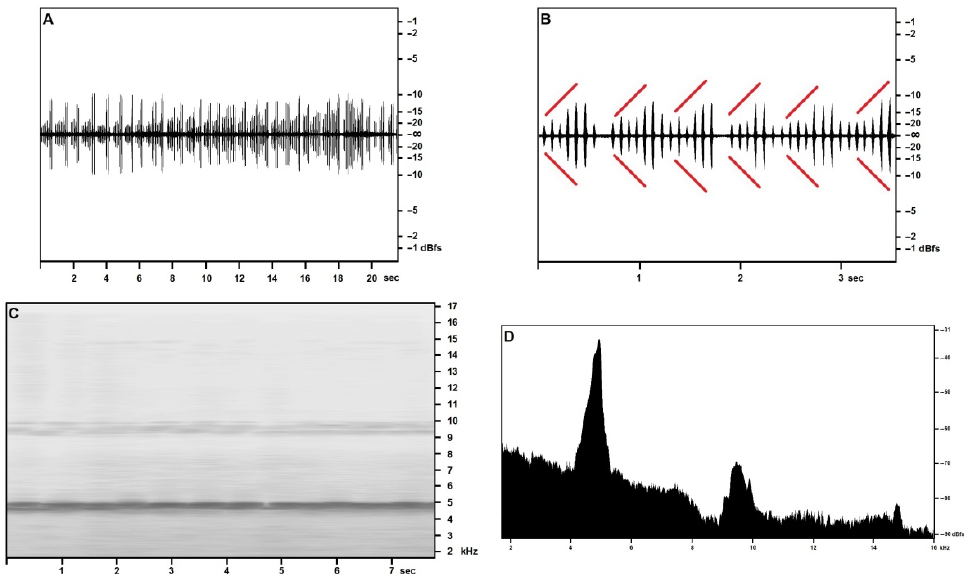
Figure 3. Acheta pantescus n. sp., “type 2” Song—( A ), Sound Pressure Envelope, 21.5 s; ( B ), Sound Pressure Envelope, 3.5 s—diverging red lines highlight crescendo; ( C ), Time/Frequency Spectrogram; ( D ), Frequency/Sound Pressure analysis, scan on two seconds.